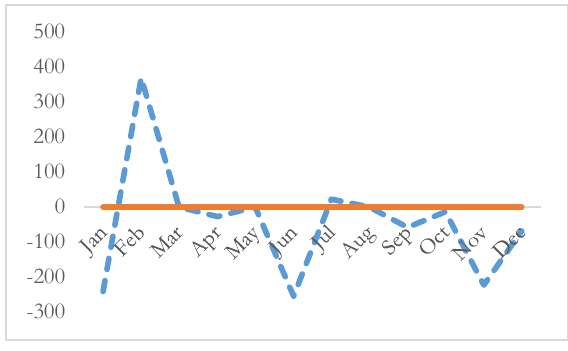
Fig. 1. Backlog and